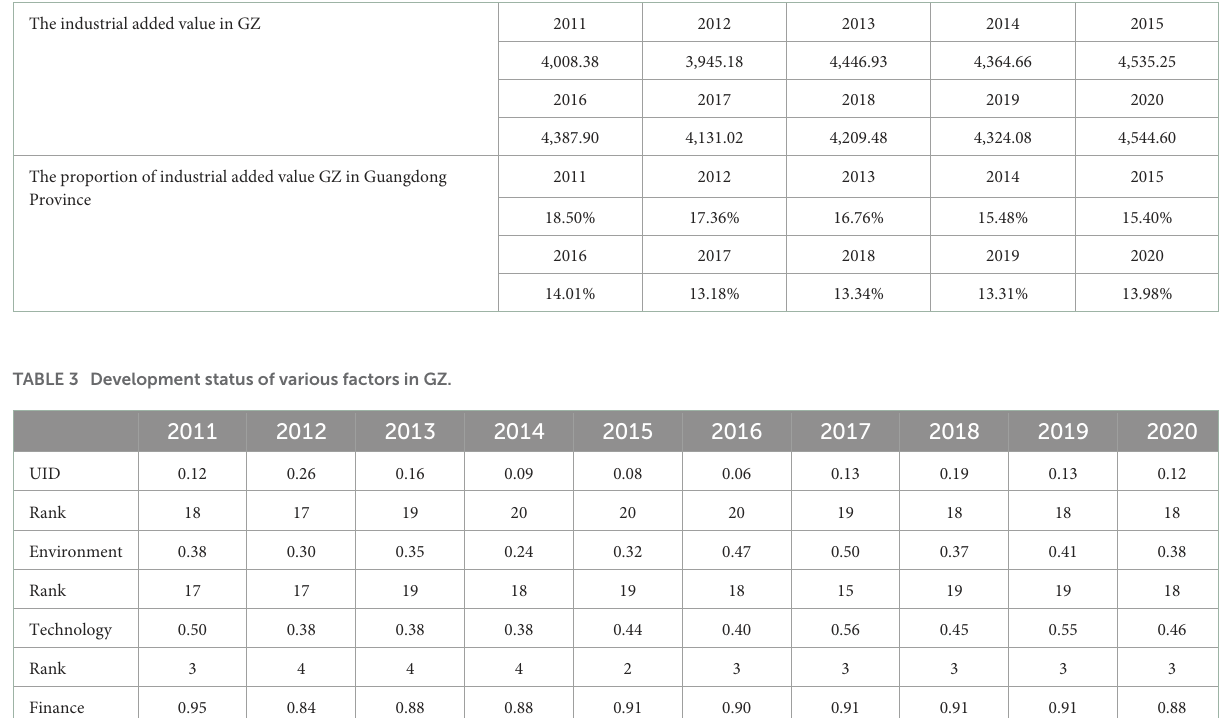
TABLE 2 Current situation of industrial added value in GZ.